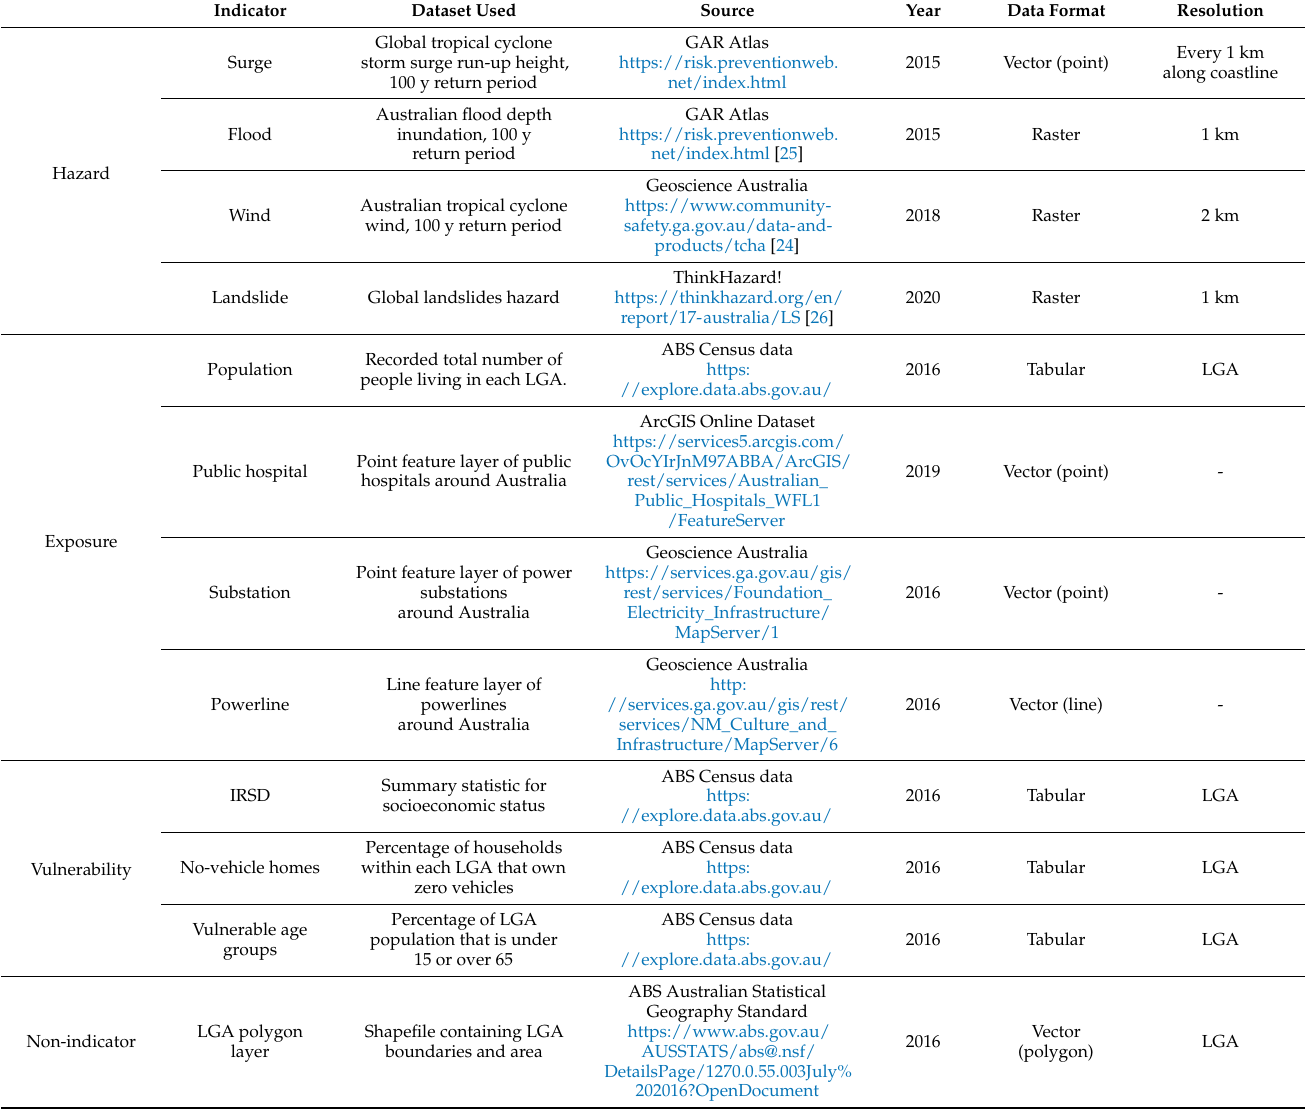
Table 2. Data used for LGA risk analysis. It contains information on the dataset used, the indicator it contributed to, where and when it was sourced from, as well as the data’s format and